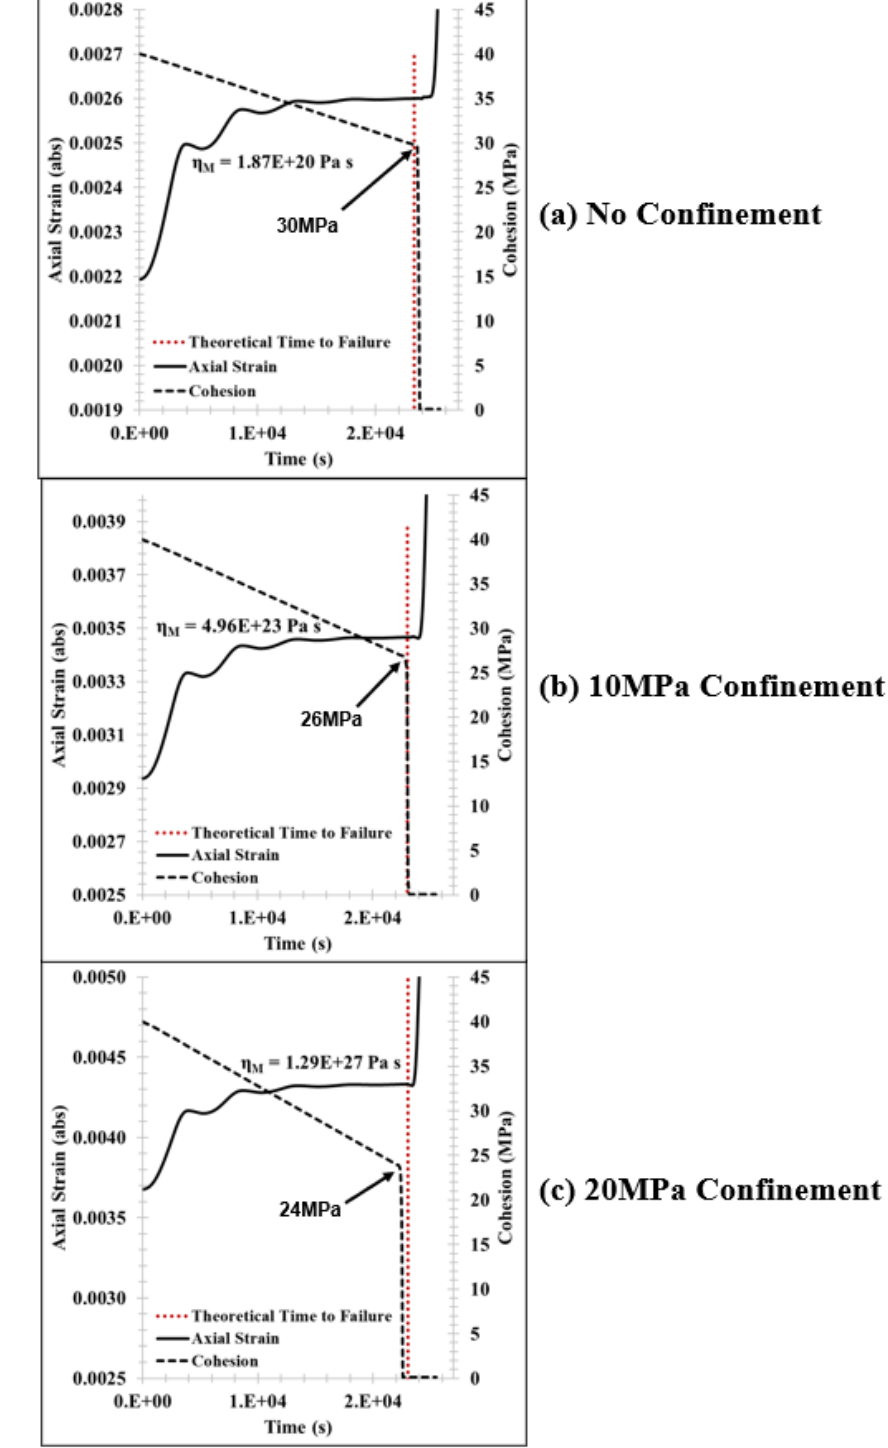
Figure 12. Axial strain and cohesion with time under a constant applied stress for ( a ) no confinement, ( b ) 10 MPa confinement and ( c ) 20 MPa confinement. All models are run with a DSR of 0.75 and failure is marked by the rapid decrease in cohesion with time. The cohesion value at failure is shown for each run.